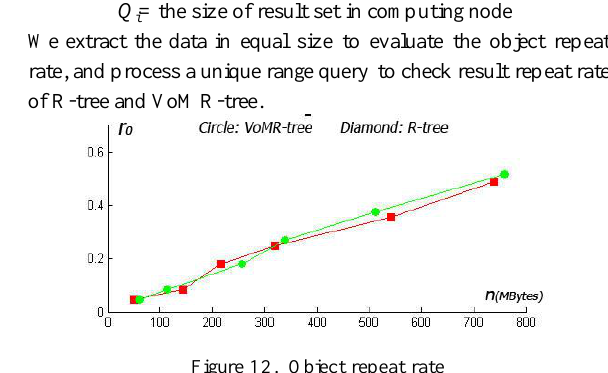
Figure 12. Object repeat rate